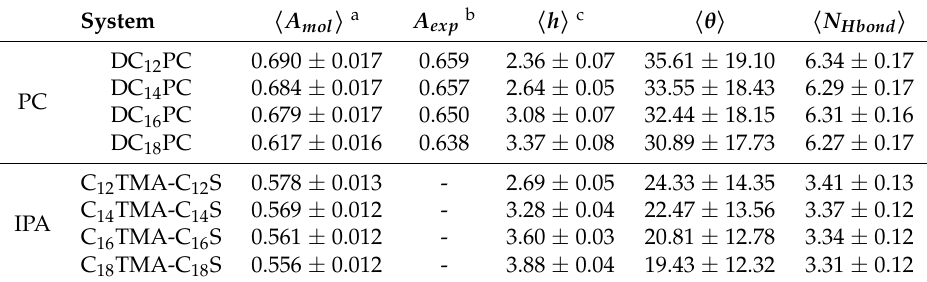
Table 1. The average molecular area (cid:104) A mol (cid:105) , experimental value of area per lipid A exp , membrane thickness (cid:104) h (cid:105) , molecular tilt angle (cid:104) θ (cid:105) , and number of H-bonds with water (cid:104) N Hbond (cid:105) for DC n PC and C n TMA-C n S IPA bilayers at 366